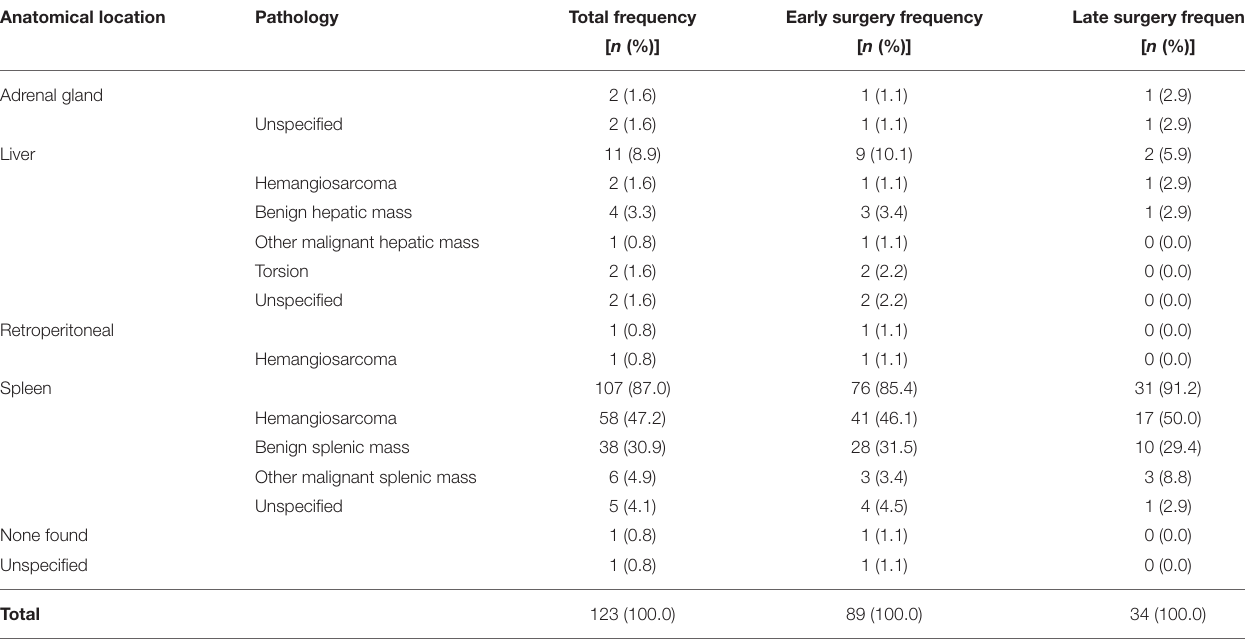
TABLE 3 | Etiology of cases which had early ( < 12h) ( n = 89) vs. late surgery ( n = 34). Anatomical